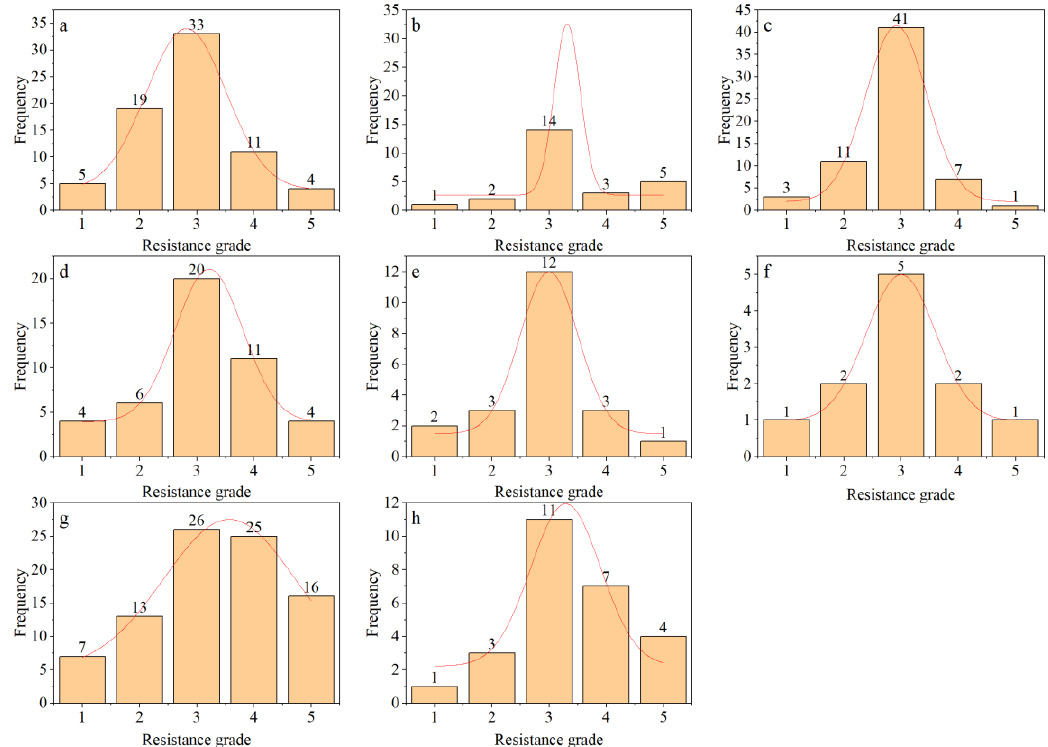
Figure 1. Histogram of frequency distribution of disease resistance grades in progeny of eight combinations exhibiting resistance. ( a – h ) correspond to hybrid combinations 1, 2, 3, 4, 5, 6, 7, and 8.